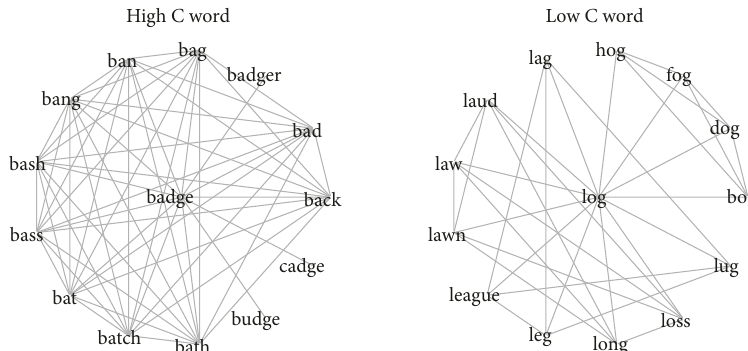
Figure 2: A word with high clustering coefficient (Left) and a word with low clustering coefficient (Right) are shown below. Notice that both words have the same number of phonological neighbors, i.e., degree. Adapted from Chan & Vitevitch [30].